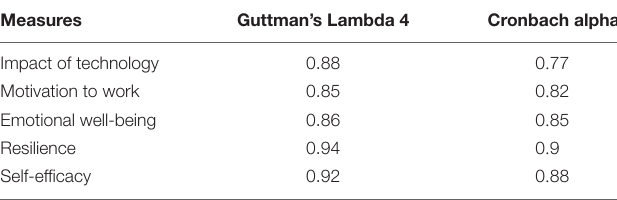
TABLE 1 | Split-half and Cronbach alpha values for measures used in study 3.